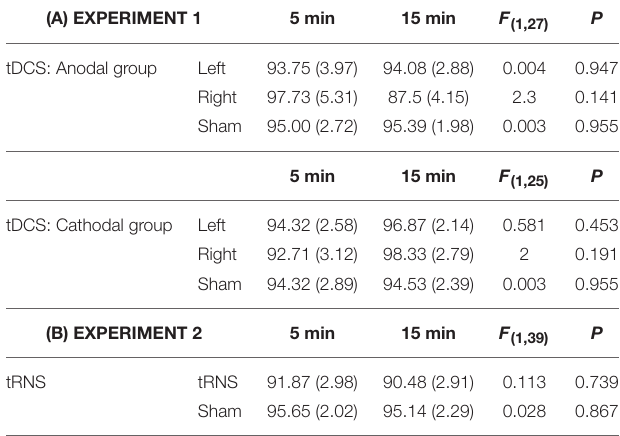
TABLE 2 | Results of the one-way ANOVAs in which the percentage of the illusory response categories (low/high-pitched tones in the left/right ear) was used as dependent variable, and the duration of stimulation before the beginning of the task (Short: 5 min; Long: 15 min) was used as between-subjects